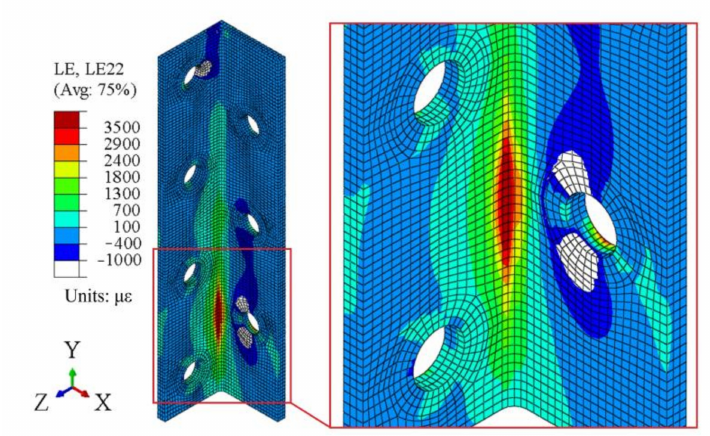
Figure 13. Transversal logarithmic strain (LE22) in the connecting angle (local direction 2), for M = 19.50 kNm at the